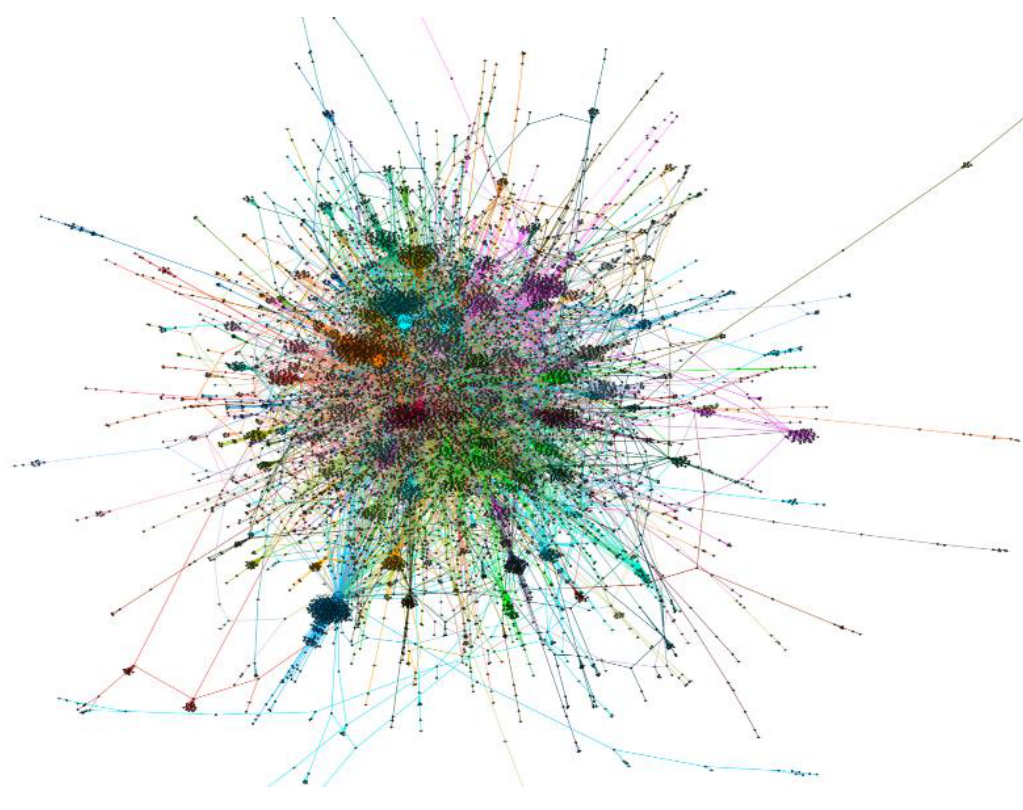
Figure 2. At the core of the